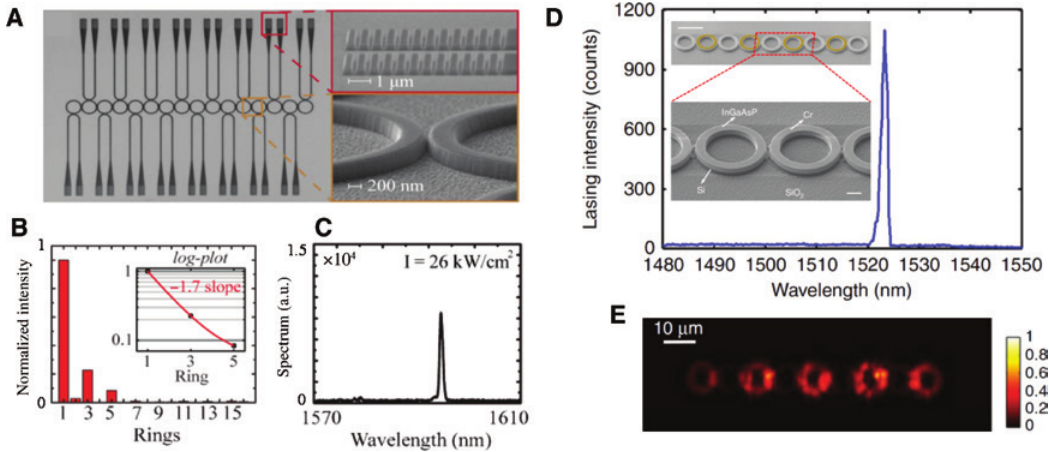
Figure 3: 1D topological microring cavity lasers. (A) Scanning electron microscope image of the lattice of ring resonators with staggered coupling engineered by Parto et al. [25]. (B) Measured intensity of the lasing mode showing the characteristic sublattice asymmetry of the topological edge state. (C) Spectrum of the topological lasing mode. (D) Measured lasing emission from the interface state engineered by Zhao et al. [27]. The inset shows scanning substrate. (E) Measured spatial shape of the laser emission electron microscope images of the coupled ring resonators fabricated on a SiO 2 centered around a topological interface state. (A–C) Adapted from Ref. [25]. (D, E) Adapted from Ref.